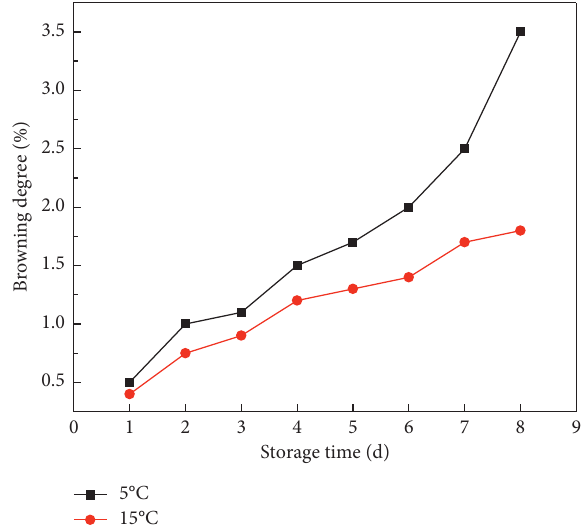
Figure 3: Analysis results of browning degree of potato